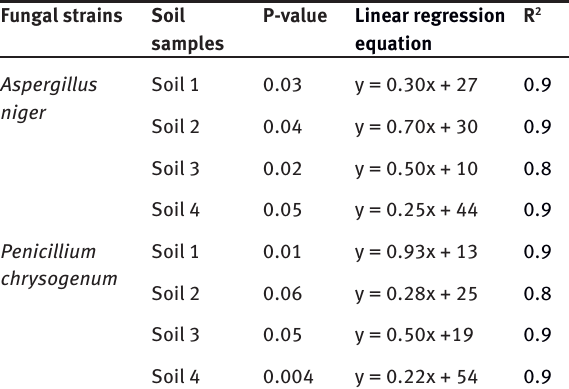
Table 6: Linear regression analysis and analysis of variance on Bensulfuron-methyl biodegradation by